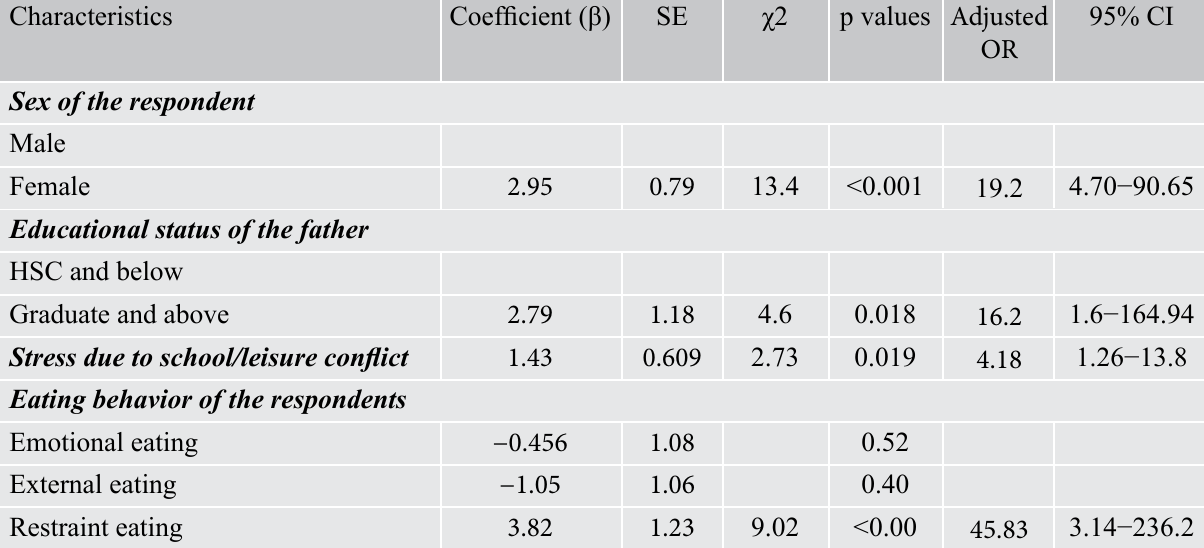
Table IV: Predictors for adolescent BMI adjusted for other factors (N=278)